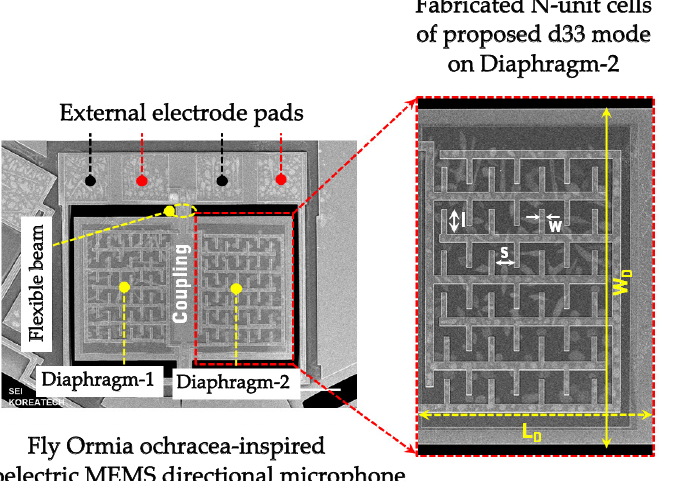
Figure 10. Scanning Electron Microscope (SEM) image of a fabricated biomimetic piezoelectric MEMS directional microphone [25]. L D (880 µm) and W D (1200 µm) are each individual diaphragm’s length and width, respectively. The inset shows in detail the planar interdigitated structure implemented to exploit the d 33